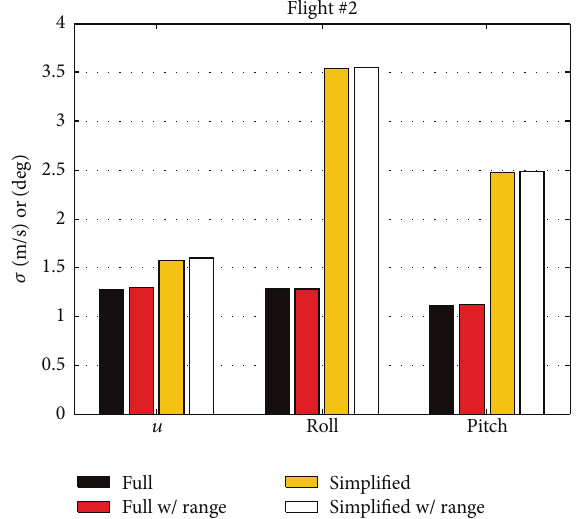
Figure 14: Graphical comparison of standard deviation of error for Flight